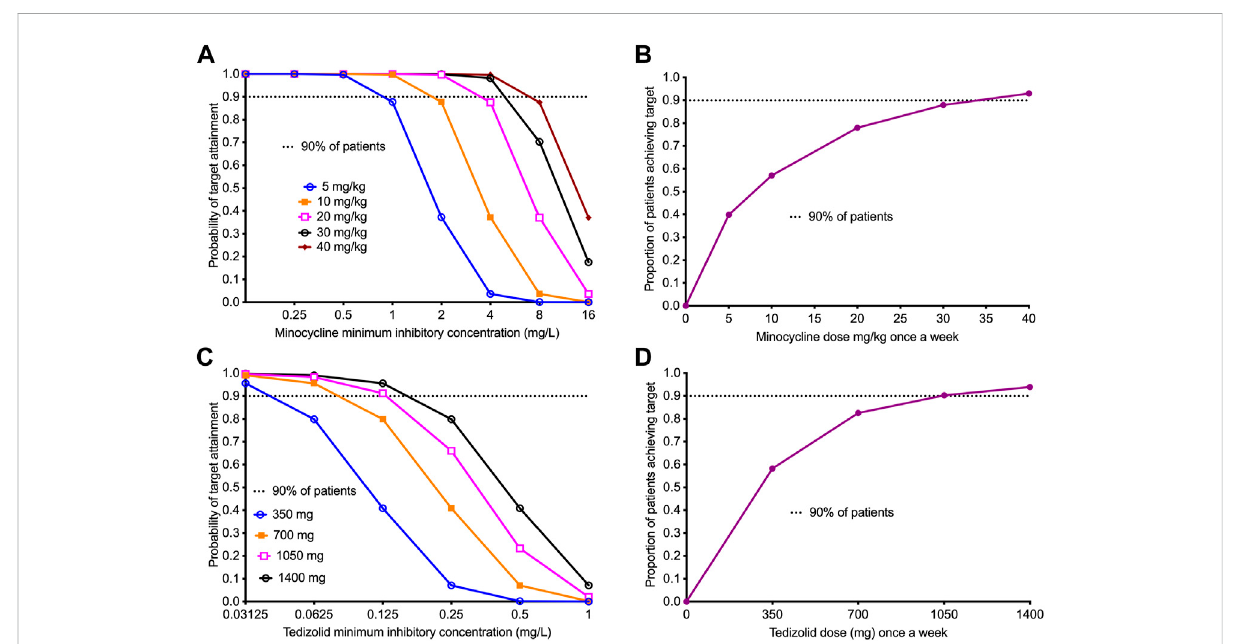
FIGURE 5 Performance of once-a-week minocycline and tedizolid doses in 10,000 virtual patients with tuberculosis . All data points show the proportion of 10,000 patients treated with a dose and dosing schedule who would achieve or exceed the target AUC/MIC exposure associated with optimal effect. 95% con fi dence intervals were very tight and virtually overlapped with prediction (not shown in the fi gure). (A) The target attainment probability (TAP) for minocyclinedoses administered once-a-week with theincreasing MIC. The TAP of90% wasachieved atdoses ≥ 30 mg/kg up to MIC of 8 mg/L, beyond which the TAP declines indicating that 8 mg/L would be the susceptibility breakpoint for once-a-week dosing. (B) The fi gure shows proportion of 10,000 TB patients achieving the weekly target minocycline cumulative exposure with the different weekly doses. The dose of 30 mg/kg, just shy of the 90% target, was determined as the optimal dose for clinical use. (C) The target attainment probability (TAP) for different doses of tedizolid administered weekly with increasing MICs. The TAP with the lowest dose falls below 90% at MIC > 0.03125